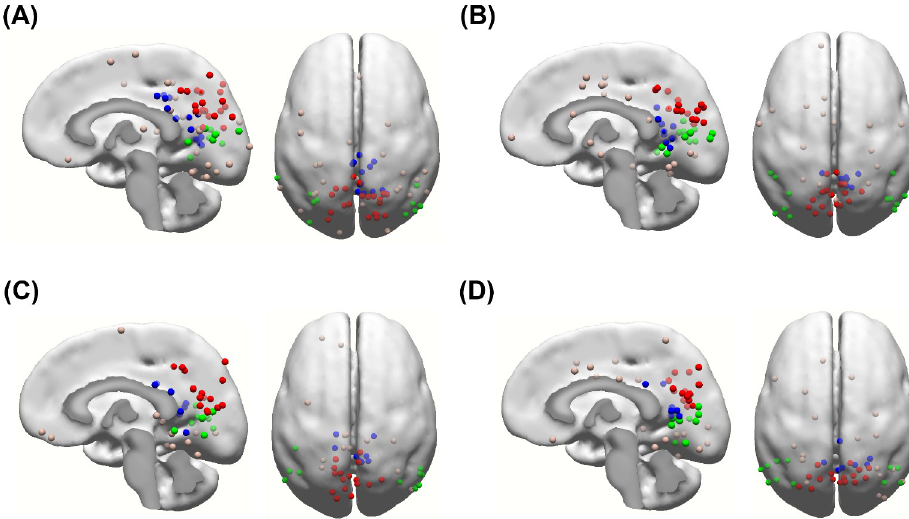
Fig 4. Distribution of equivalent current dipoles of training-induced alpha activity for the four methods. The (A) max peak average (MPA), (B) positive average (PA), (C) negative average (NA) and (D) event-related spectral perturbation average (ERSPA) methods. Note that the red dots are located close to the precuneus, the blue dots are located close to the posterior cingulate cortex (PCC), and the green dots are located close to the middle temporal gyrus.